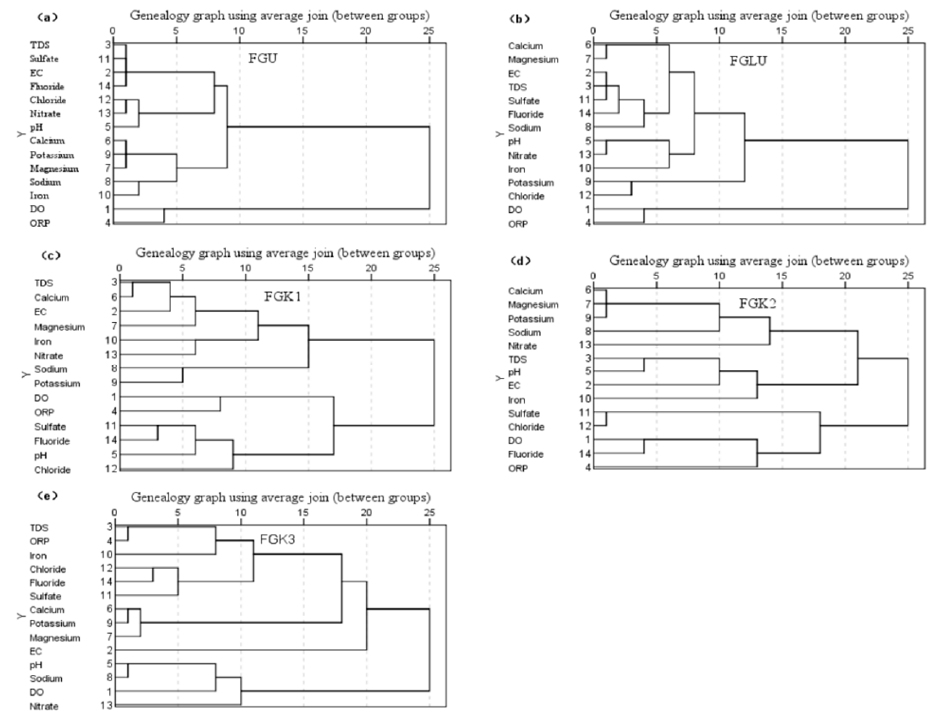
Figure 6. Correlation diagram of water quality indicators.